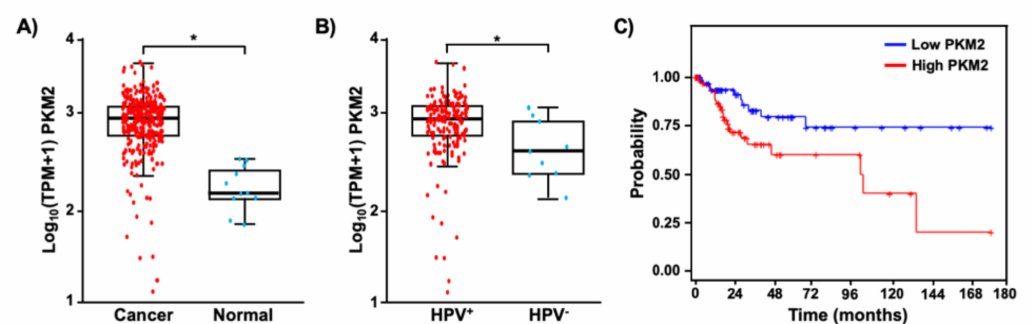
Figure 1. PKM2 is upregulated and has a prognostic value in cervical cancer. ( A ) TPM values of PKM2 mRNA in cervical cancer tissues ( n = 304) and normal cervical tissues ( n = 11) are shown in the log scale. * p = 1.3 × 10 − 6 (Welch’s unequal variances t -test). ( B ) Cervical cancer tissues shown in A were grouped based on the HPV status. The level of PKM2 mRNA was 2.1-fold higher in HPV + cervical cancer ( n = 169) than HPV – cervical cancer ( n = 9). * p = 0.05 (Welch’s unequal variances t -test). ( C ) Overall survival was worse in cervical cancer patients with high levels of PKM2 (red, n = 76) than those with low levels of PKM2 (blue, n =